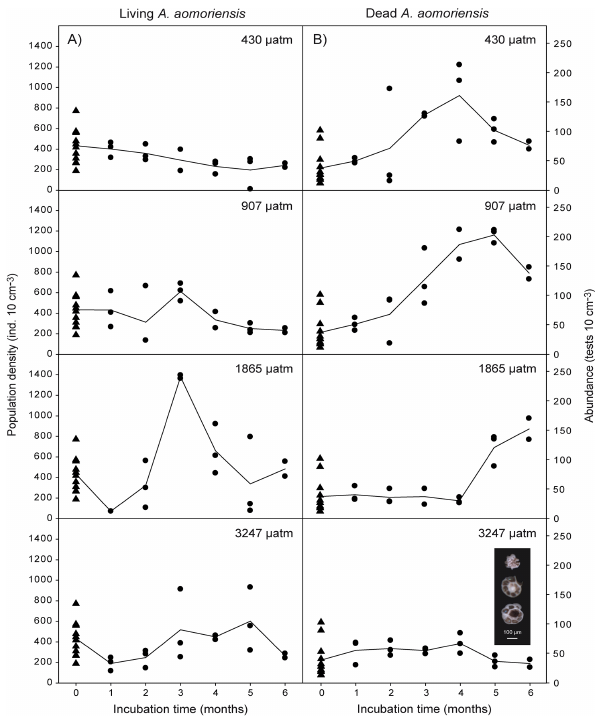
Fig. 3. (A) Population density of living and (B) abundance of dead A. aomoriensis at four p CO 2 levels (430, 907, 1865 and 3247µatm) during 6 months of incubation time. The triangles represent the initial population densities/abundances ( T = 0). Circles represent population densities/abundances of the measured replicates during the incubation time. Continuous line refers to mean of the replicate measurements.